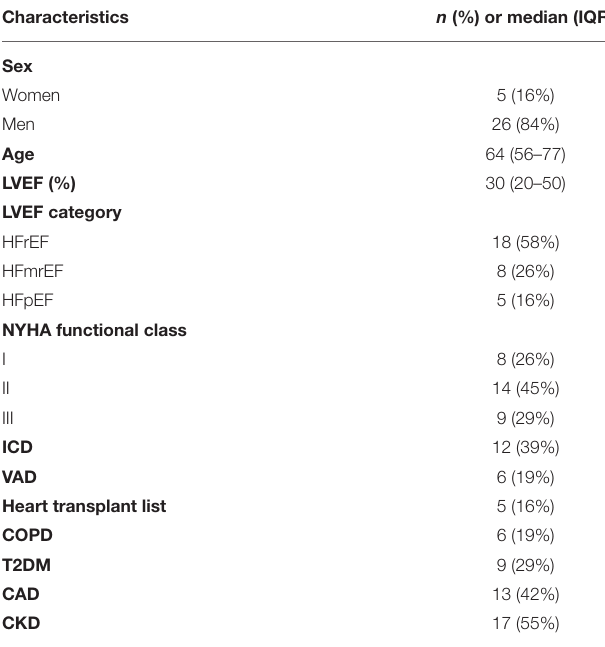
TABLE 1 | Characteristics of the patients included in the study ( n = 31).